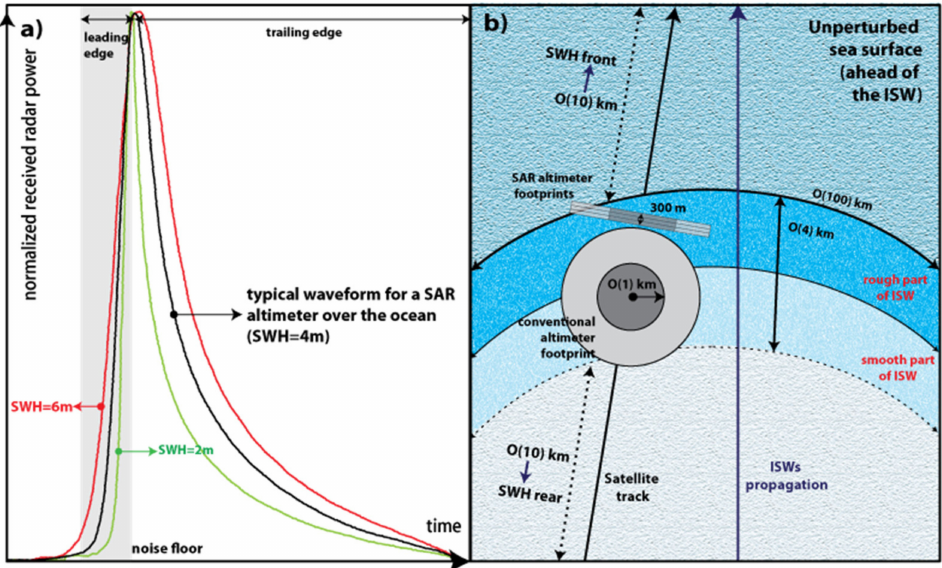
Figure 3. ( a ) Normalized SAR altimeter waveforms for an unperturbed (in relation to the ISWs’ surface manifestations) sea surface (black) and for different SWHs (green and red). ( b ) Schematic repre- sentation of a typical ISW and footprints of a conventional (circular shape) and a SAR altimeter (SRAL, rectangular shapes). Dark gray represents illuminated areas corresponding to maximum backscattered power, and light gray the decaying part of the echo due to off-axis antenna gain